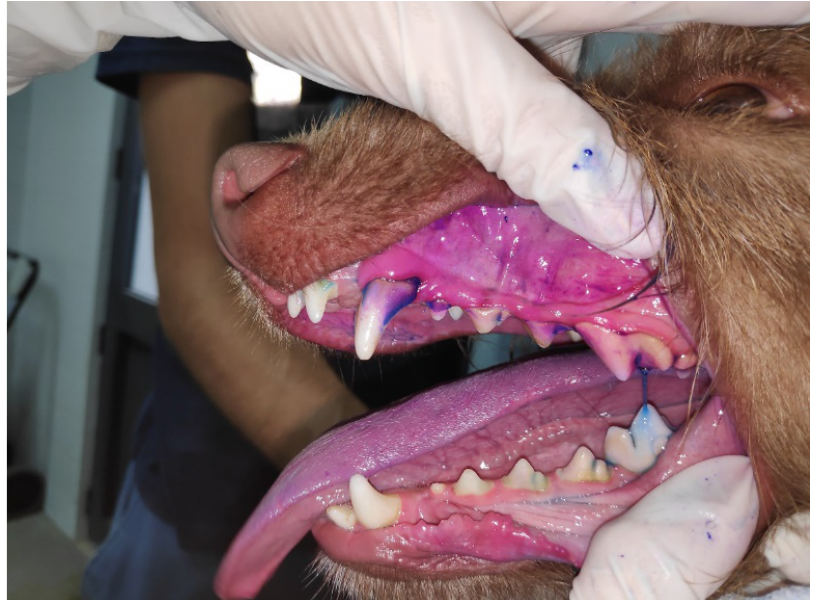
Figure 1. Observation of the dental plaque in the oral cavity of a dog, by using a disclosure